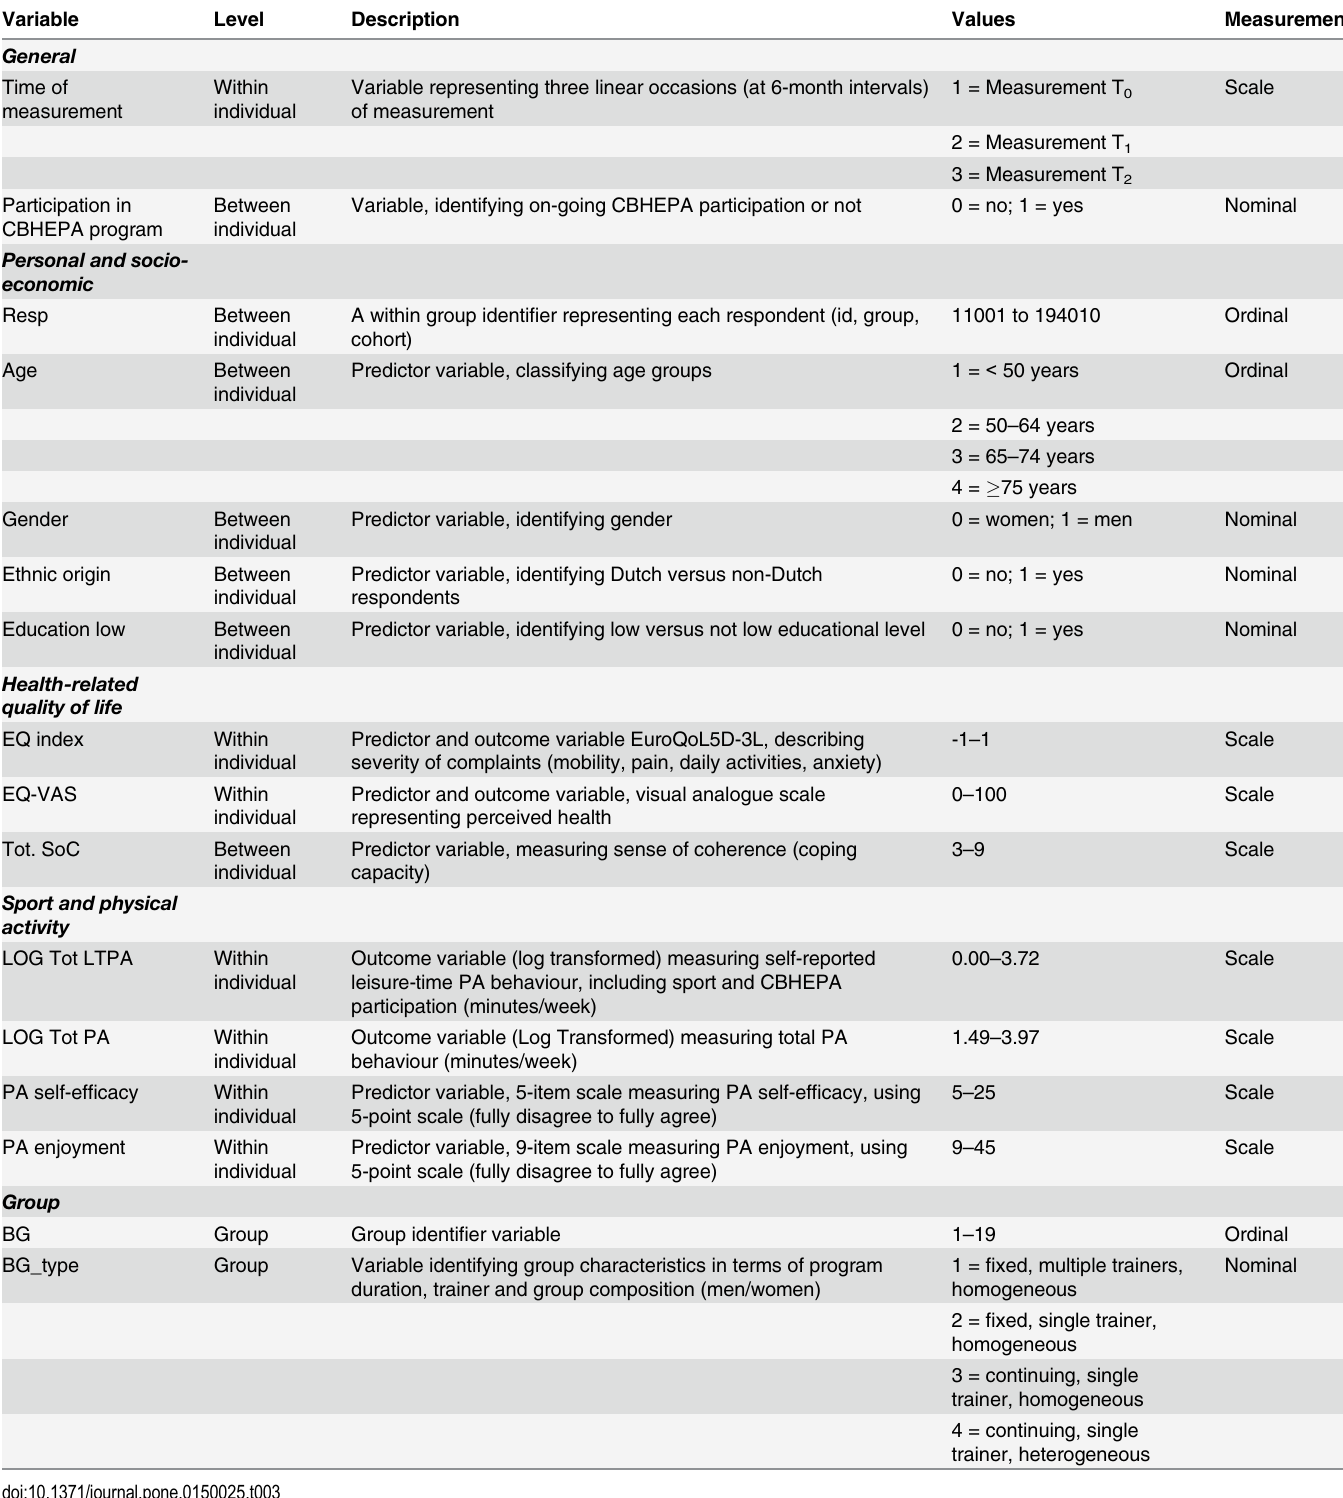
Table 3. Data definition for multilevel longitudinal analysis of PA